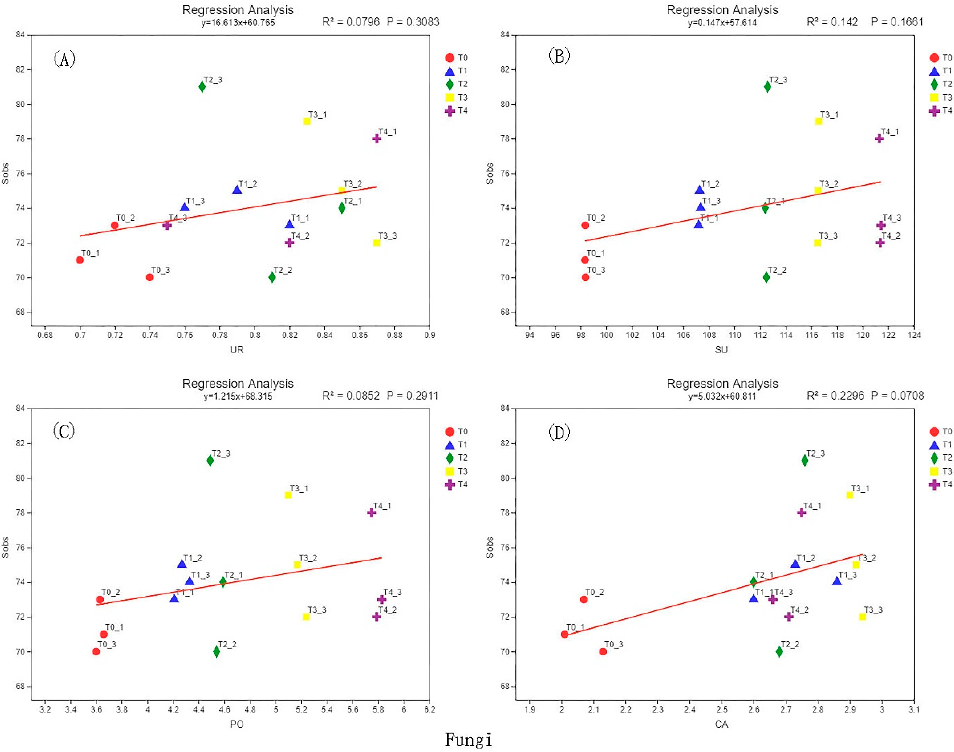
Figure 5. Regression analysis of fungal ordination. ( A ) The environmental factor is urease (UR); ( B ) the environmental factor is sucrase (SU); ( C ) the environmental factor is polyphenol oxidase (PO); ( D ) the environmental factor is catalase (CA).